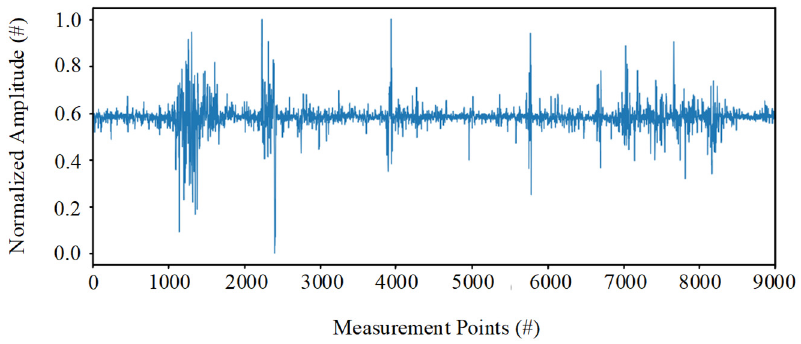
Figure 4. An example of normalized amplitude of the whole track at a certain moment.